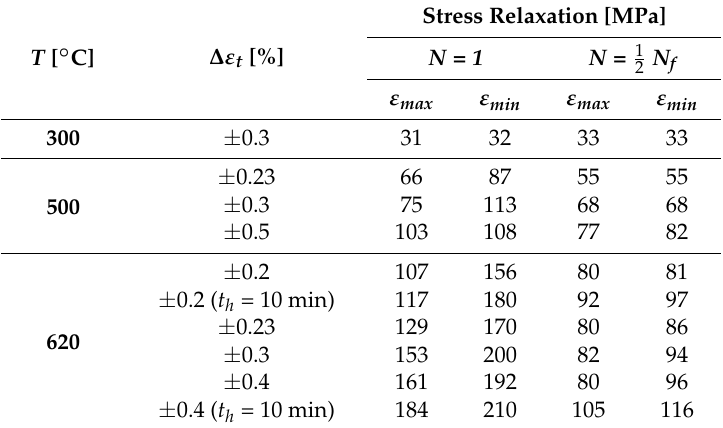
Table 6. Amounts of stress relaxation in the different RF-tests, given in absolute values. For comparison purposes, the individual values obtained in tension and compression for N = 1 and N = N f /2 are given.